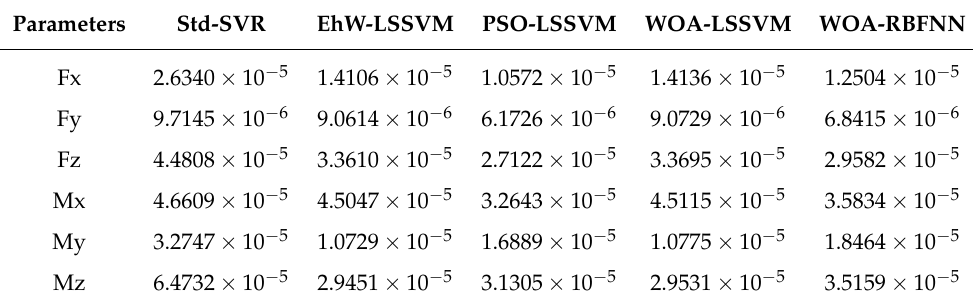
Table 3. Compensation results on the training set by different methods.